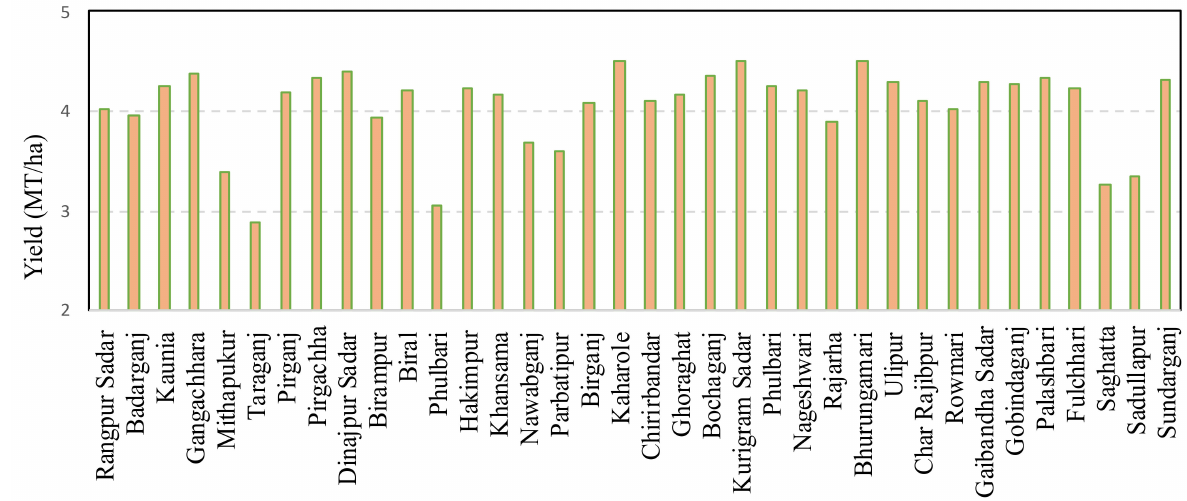
Figure 8. Ground reference rice yield distributions in the 36 subunits.